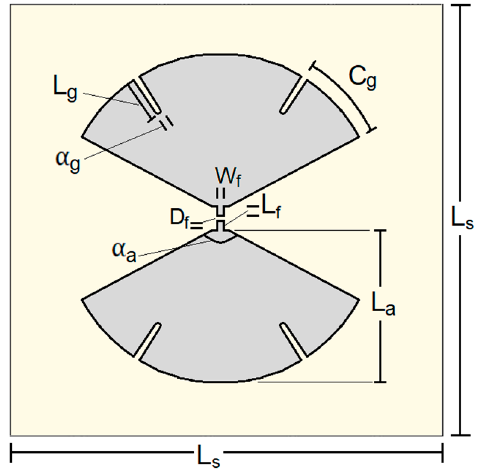
Figure 6. Rounded-edge bow-tie with grooves and its parameters.